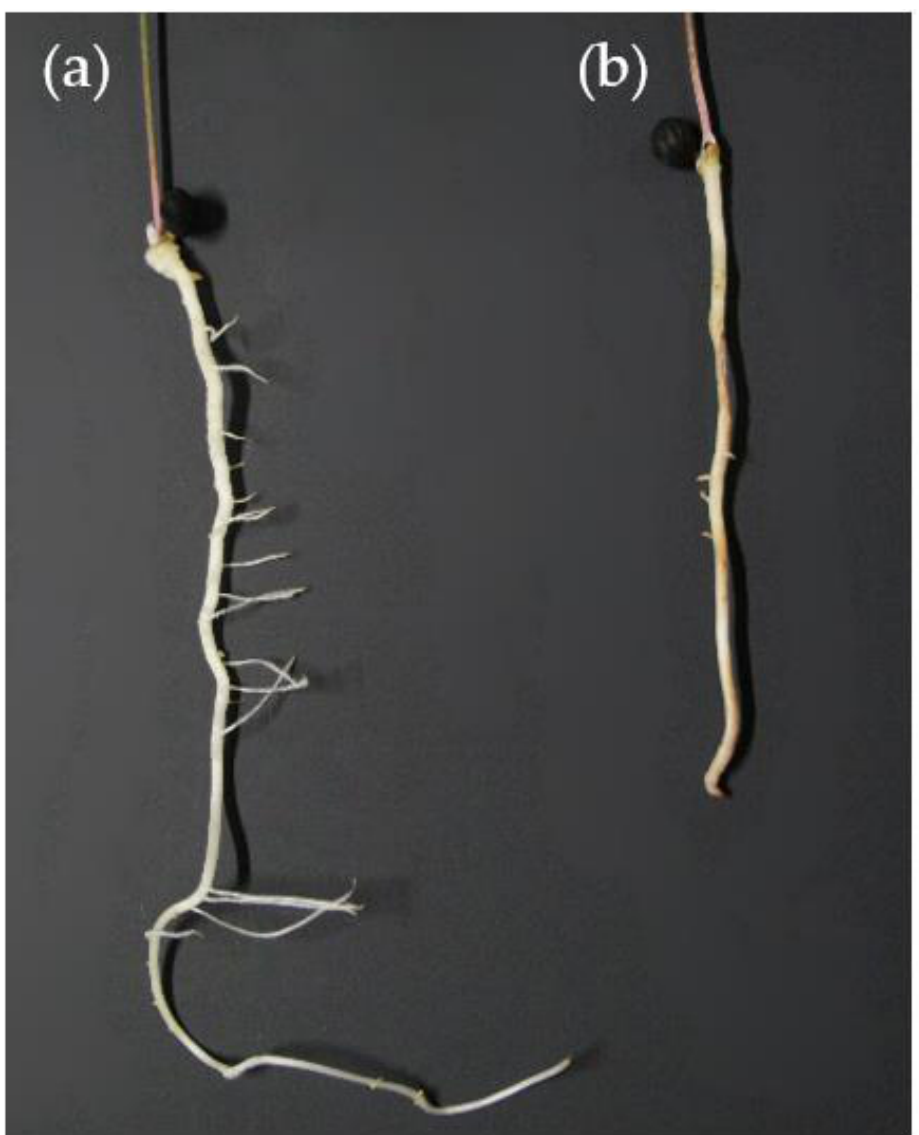
Figure 1. A. officinalis cv. Ramada 14 dpi with F. oxysporum . ( a ) Control; ( b ) Foxy III. Infection with F. oxysporum was indicated mainly by elongated brown spots and by the discoloration of entire root sections. In severe infection symptoms, purple exudates were released sometimes on the filter paper, and/or the roots disintegrated partially. In rare cases, a white mycelium formed on the infected root. Differences in virulence between Foxy II and Foxy III were indicated by visibly fewer browning symptoms and a smaller infected area in Foxy